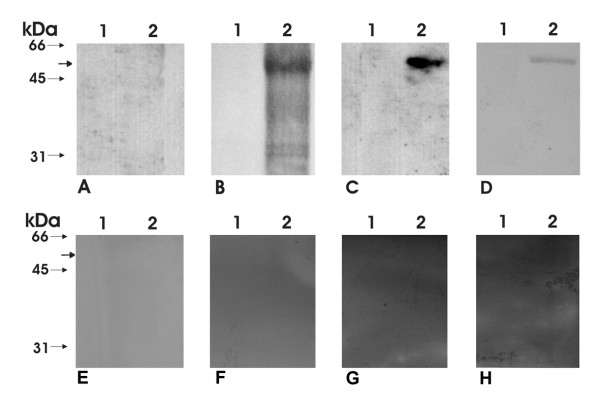
Sera from immunized rabbits contain anti-E2-specific antibodies. Pre-immune sera (A and E) and sera from rabbit immunized with PVX6HisE212ACP (B, C, D) and with PVX6His2ACP (F, G, H) were tested by Western blotting for antibody reactivity against E2 (indicated with a bold arrow) protein (lanes A2, B2, C2, D2, E2, F2, G2 and H2). Western blotting was carried out using serial dilutions 1/10 (B and F), 1/100 (C and G), 1/1,000 (D and H) and pre-immune sera 1/100 (A and E). Lanes A1, B1, C1, D1, E1, F1, G1, and H1 represents Standards Molecular weight.